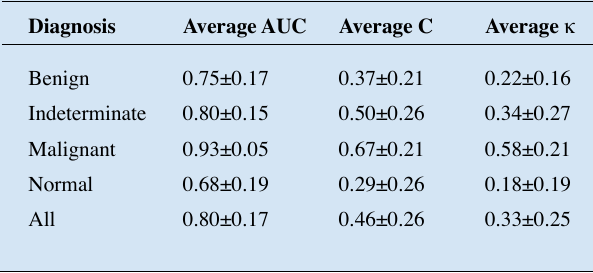
Table II. Average of the best matching results for TM- matching